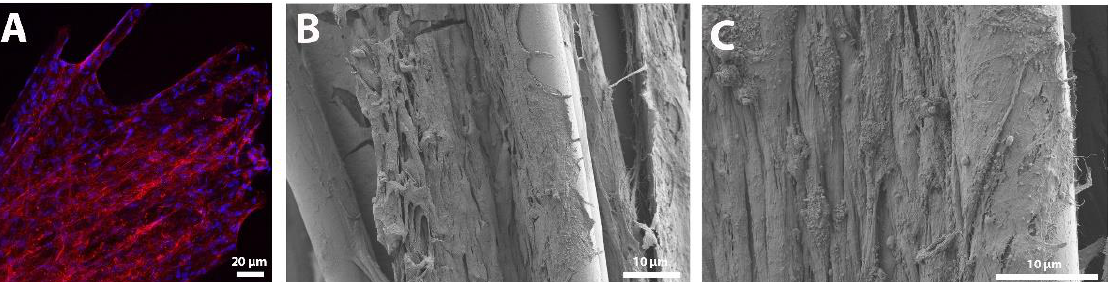
Figure 4. Confocal and field emission scanning electron microscope (FESEM) images of the cellular conduits. ( A ) Confocal image of human Schwann cells (hSC) seeded on the polylactic acid (PLA) microfiber bundle. The cytoskeleton of hSC is observed in red (phalloidin) and the nuclei of cells is observed in blue (DAPI). ( B , C ) FESEM images of hSC seeded on the PLA microfiber bundle. It can be observed how hSC can attach and grow on PLA microfibers, wrapping them ( B ). Further, an alignment of hSC cytoskeleton is observed, thanks to the topographical guidance of PLA microfibers ( C ).